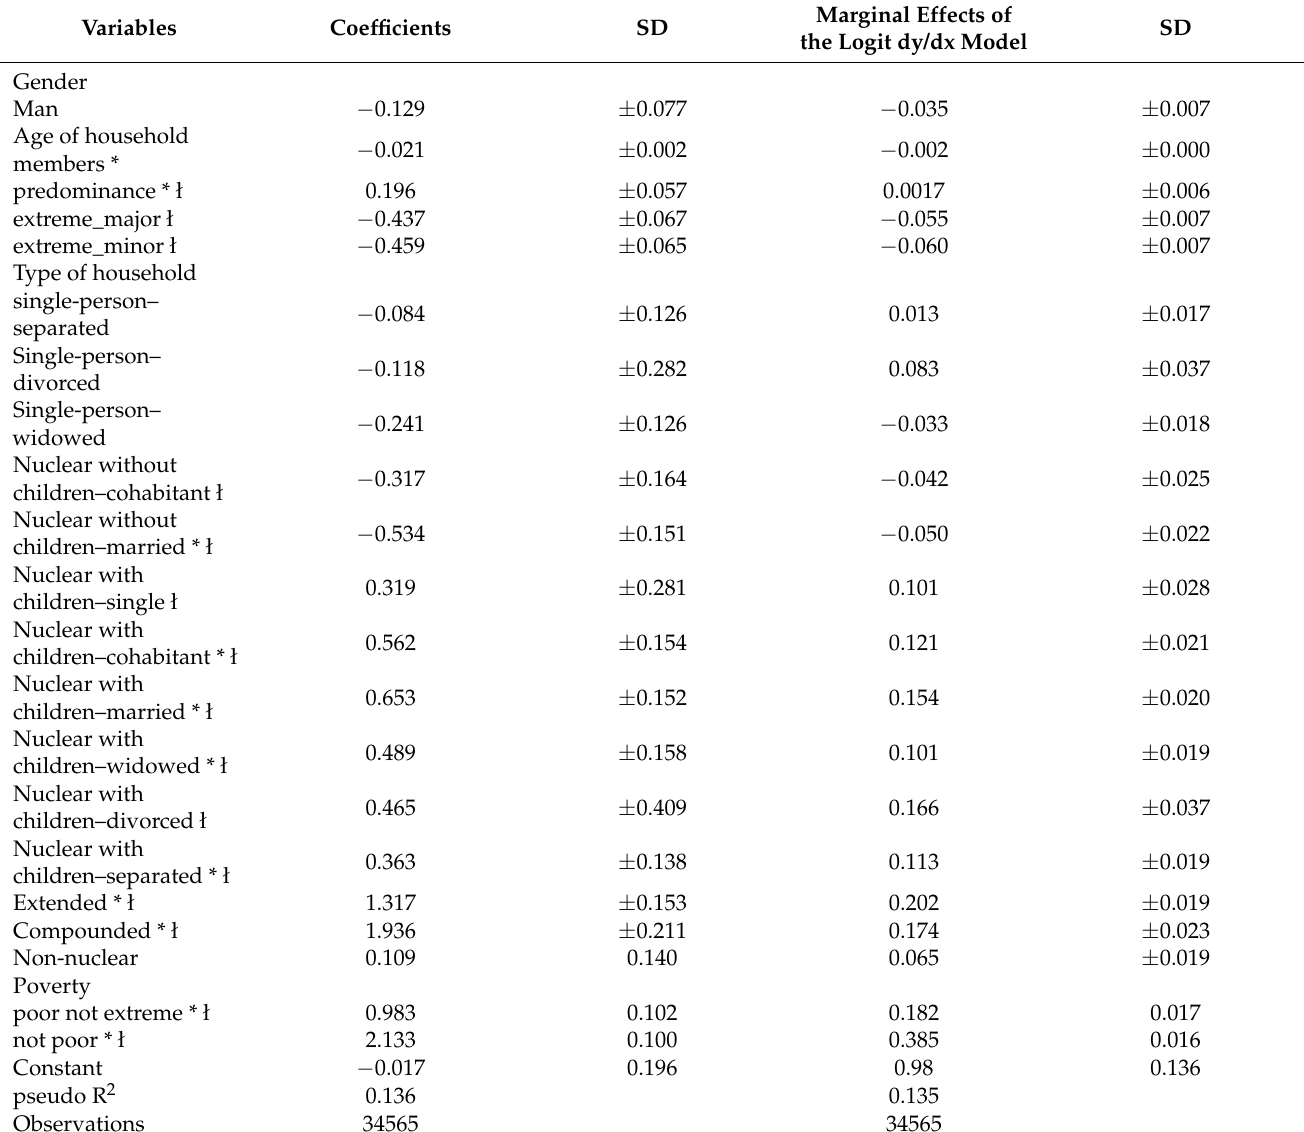
Table 3. Coefficients and Marginal Effects of the Logit